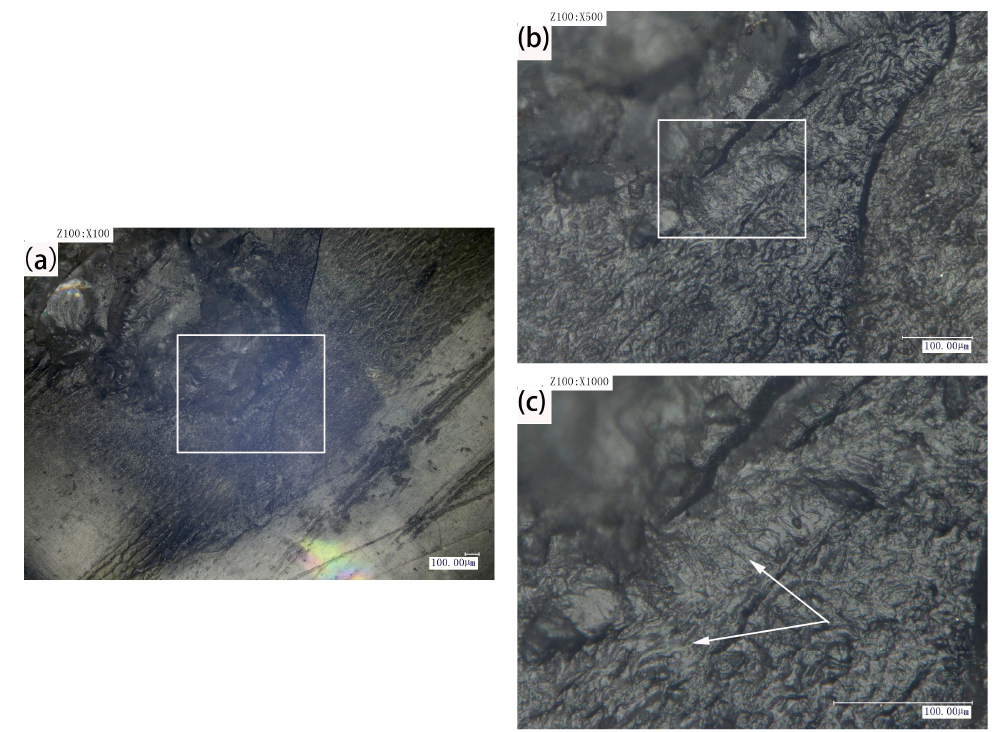
Figure 5. Post-failure images of the bond interface for the samples (type II, 480 V, 6 mm), ( a ) magnified 100 times; ( b ) magnified 500 times; ( c ) magnified 1000 times.